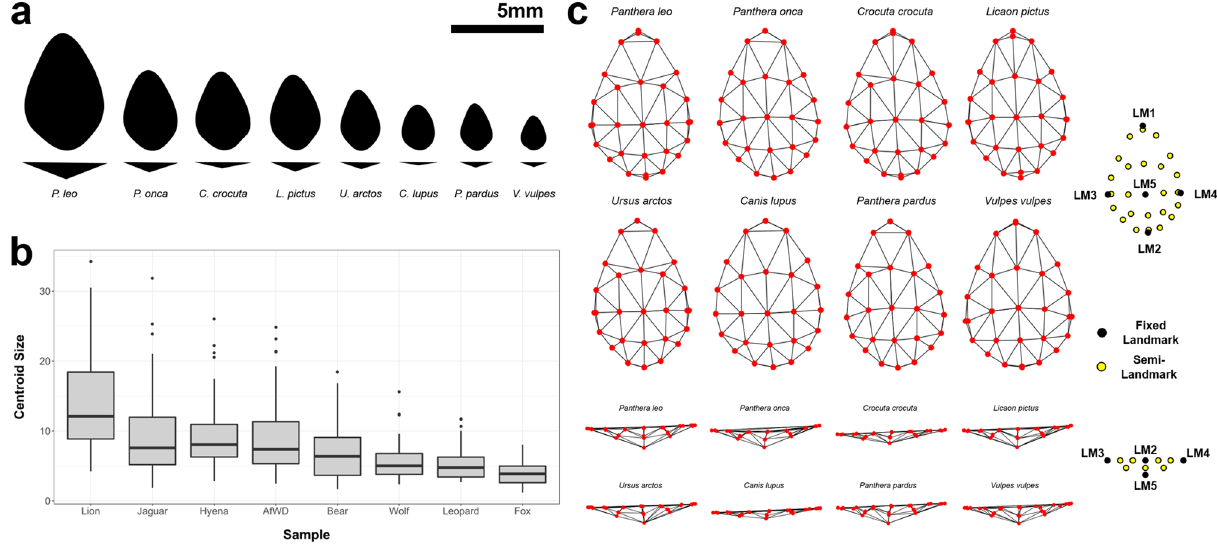
Figure 1. Variations in Form and Shape across tooth pits made by different taxa. ( a ) Variations in mean shape- size relationships (top-view used for general morphology and front-view for depth). ( b ) Boxplot diagrams representing centroid size distributions for each species (See Supplementary Table 1). ( c ) Mean landmark configurations for carnivore tooth pits using Delaunay 2.5D Triangulation algorithms for mesh visualisations. AfWD = Lycaon pictus . Figures created using the ggplot2 and scikit-learn Python and R